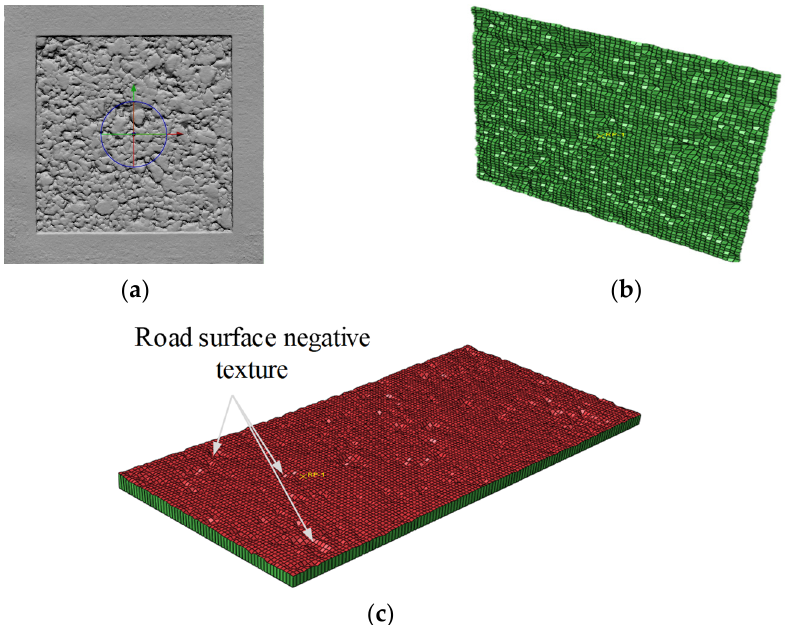
Figure 5. Generation process of textured pavement 3D FE model: ( a ) 3D model of texture morphology; ( b ) rigid shell element; ( c ) textured pavement 3D model.